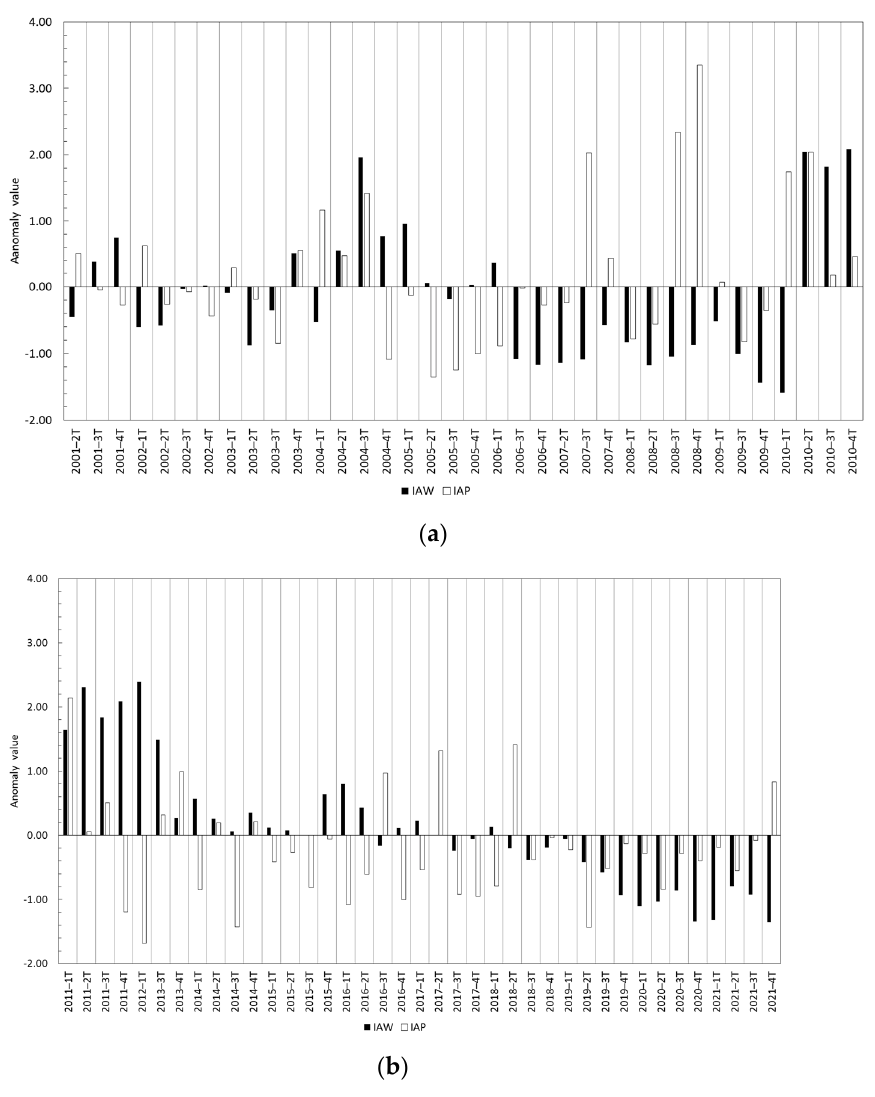
Figure 3. Water surface anomaly index (IAW) and precipitation anomaly index (IAP) in the period 2001–2010 ( a ) and 2011–2021 ( b ) .